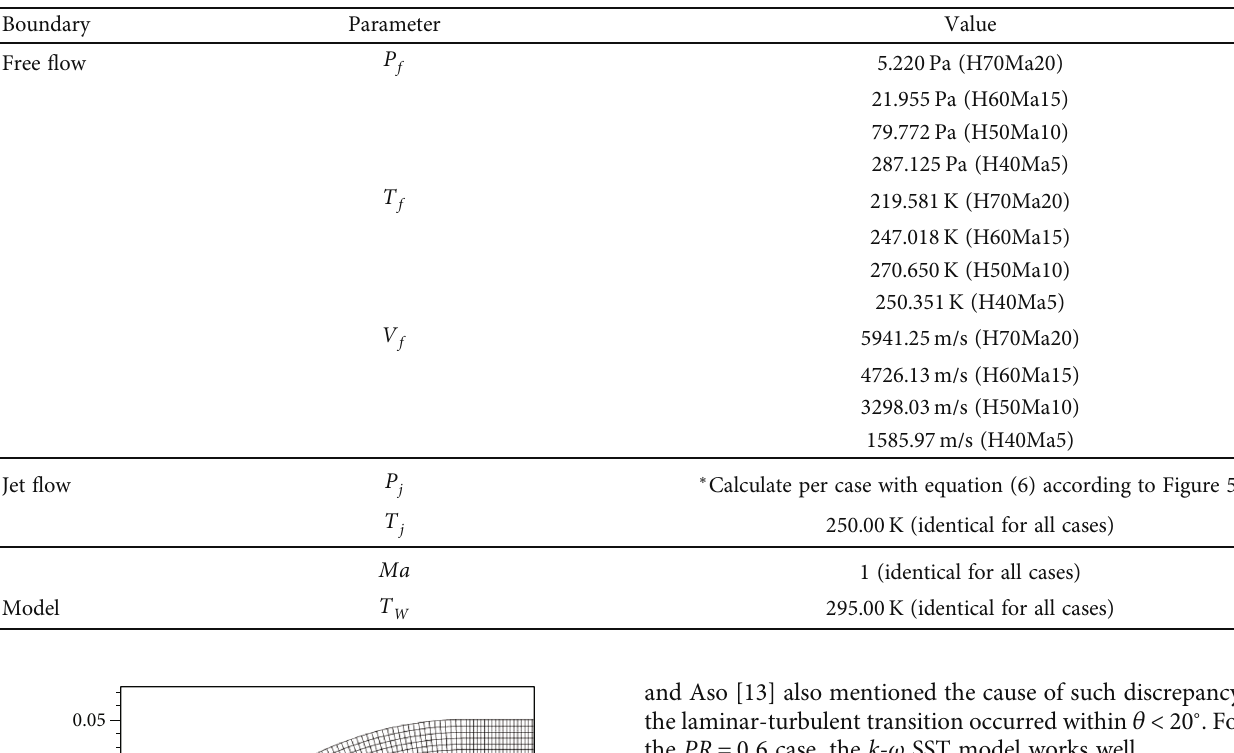
Figure 5: Comparative case design and notes. Table 1: Summary of boundary conditions.